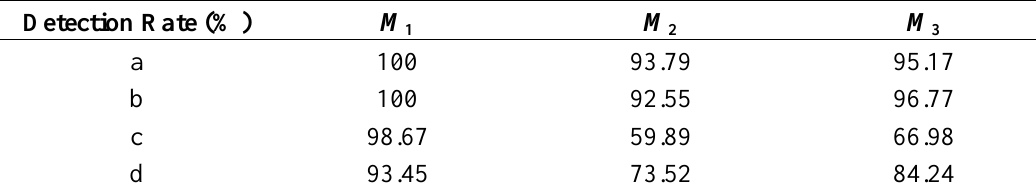
Table 2. Comparisons regarding the detection rate.